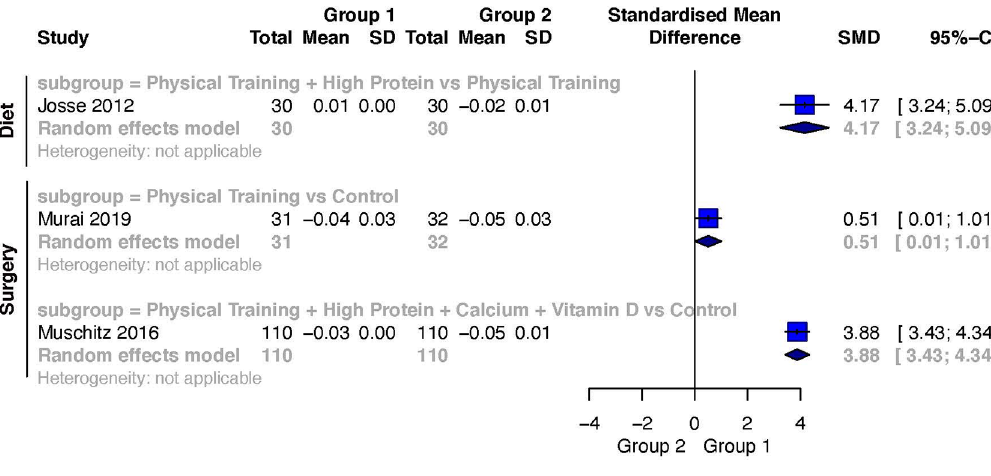
Figure7.Weightedeffectsandtheircorresponding95%CIsfortheoutcomechangescoresfortotal-bodybone mineral density during diet- and surgery-induced weight